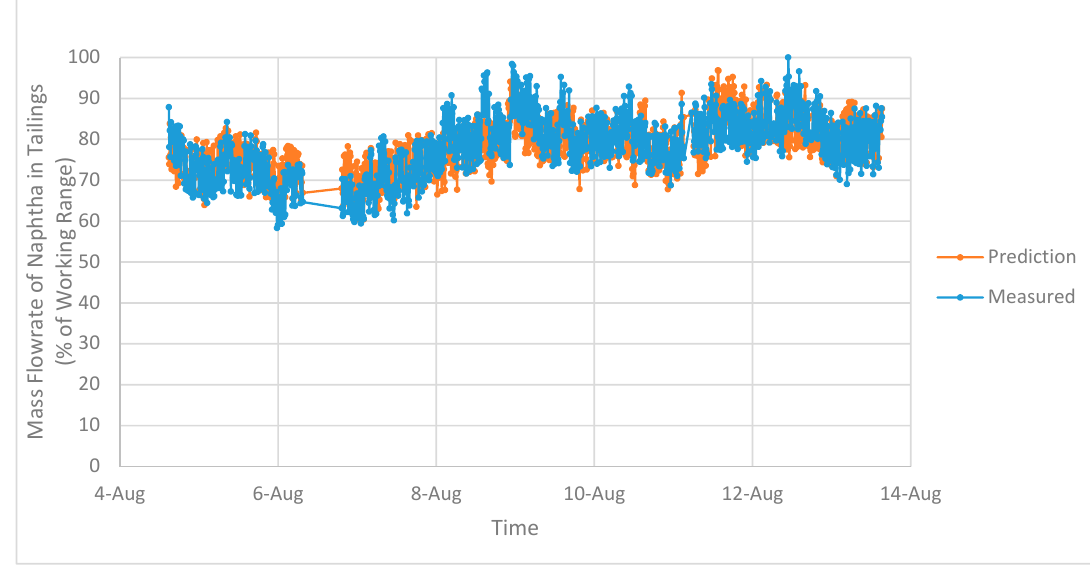
Figure 9. Measured and predicted mass flowrates of naphtha in the tailings for OP2.